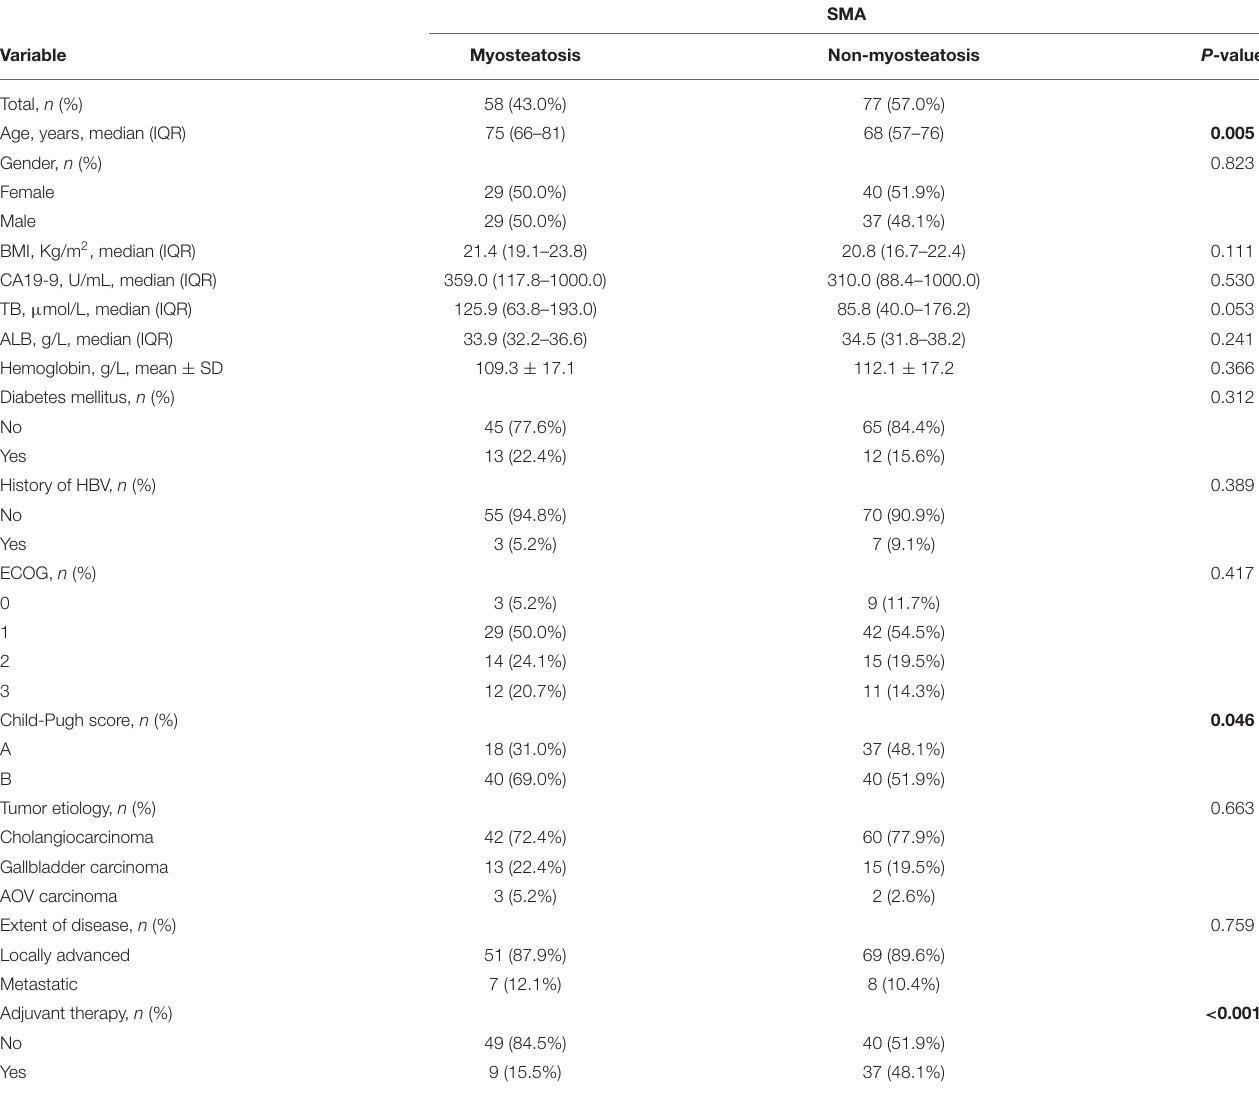
TABLE 3 | Comparison between myosteatosis and non-myosteatosis group when using SMA as an assessment tool.